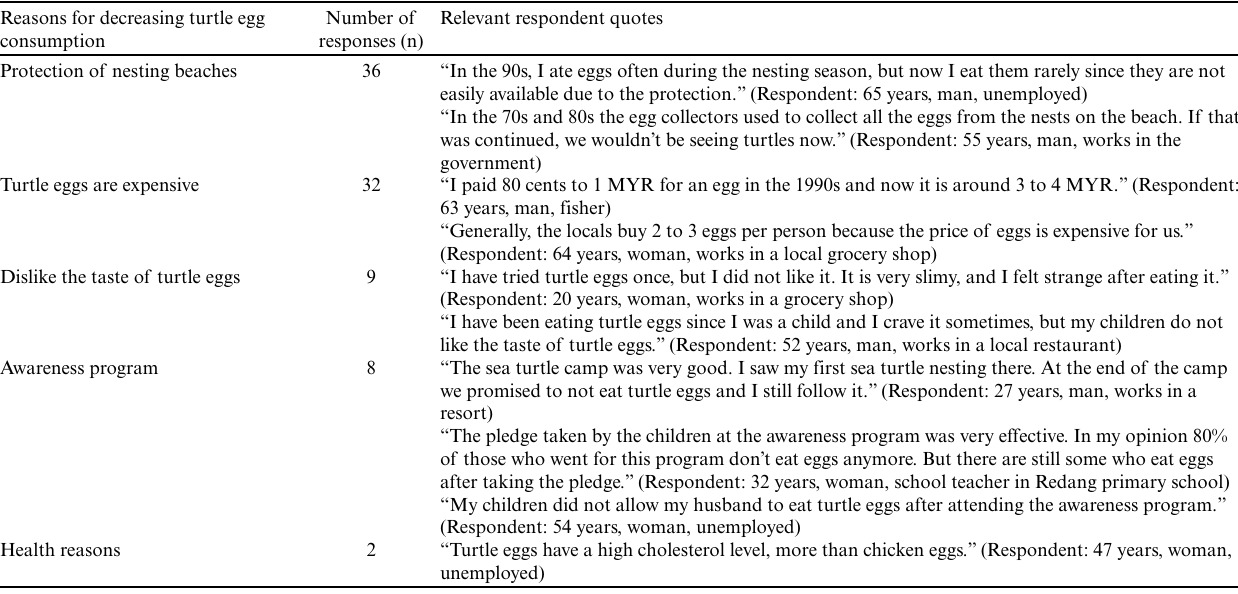
Table 3 . Reasons for the decrease in turtle egg consumption stated by the respondents, with illustrative example quotes. Reasons for decreasing turtle egg consumption